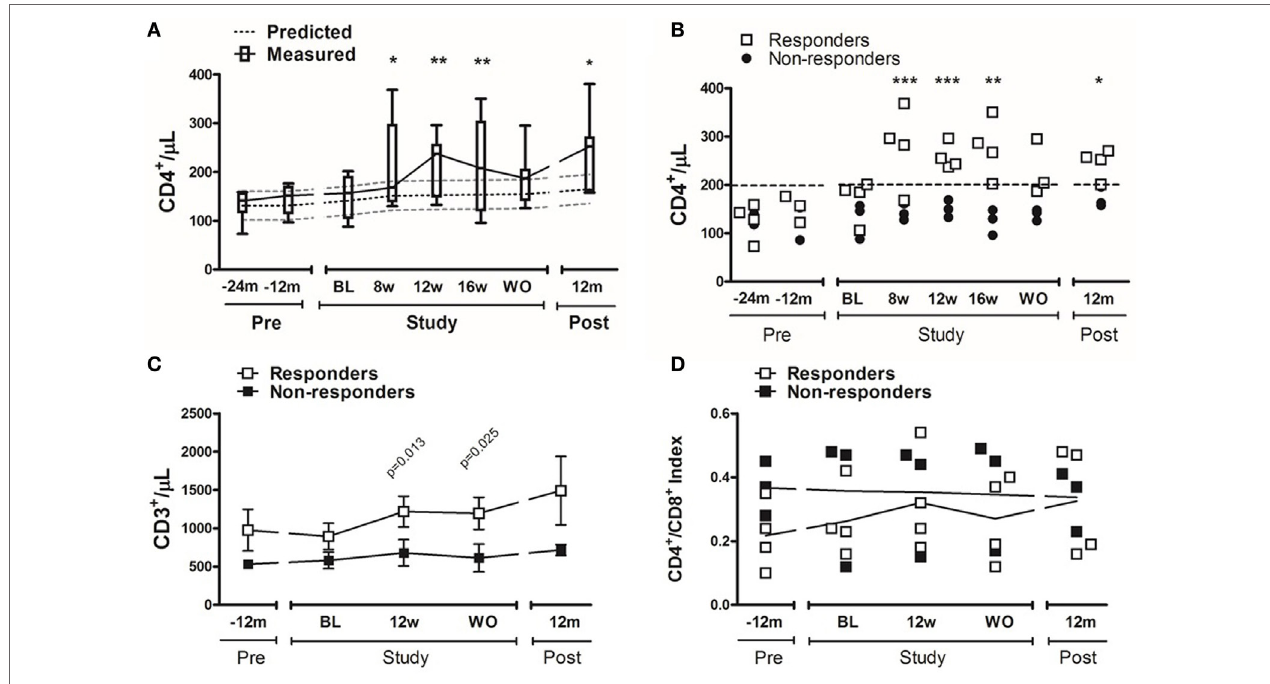
FigurE 2 | CD4 + cell increase before, during, and after pyridostigmine (PDG). Total CD4 + cell counts were determined by flow cytometry as CD3 + , CD4 + , and CD8 neg cells. (a) The solid line shows the dynamic increase of total CD4 + T-cells [median (p25–p75)] during PDG administration; for comparison, the broken lines depict predicted increase in circulating CD4 + cells of 35 cells/mL/year (4). (B) A subgroup of patients showed a significant, rapid, and persistent elevation in CD4 + cells, and this increase persisted after washout, and 1-year after PDG (each symbol represents and individual value). (C) Total T-cells were determined by flow cytometry as CD3 + cells (mean ± SD). (D) The ratio of CD4 + and CD8 + cells was determined by gating from total (CD3 + ) T-cells (each symbol represents and individual value). n = 7 for panel (a) ; n = 3–4 subjects/group for panels (B–D) . * p ≤ 0.05; ** p ≤ 0.01 vs.